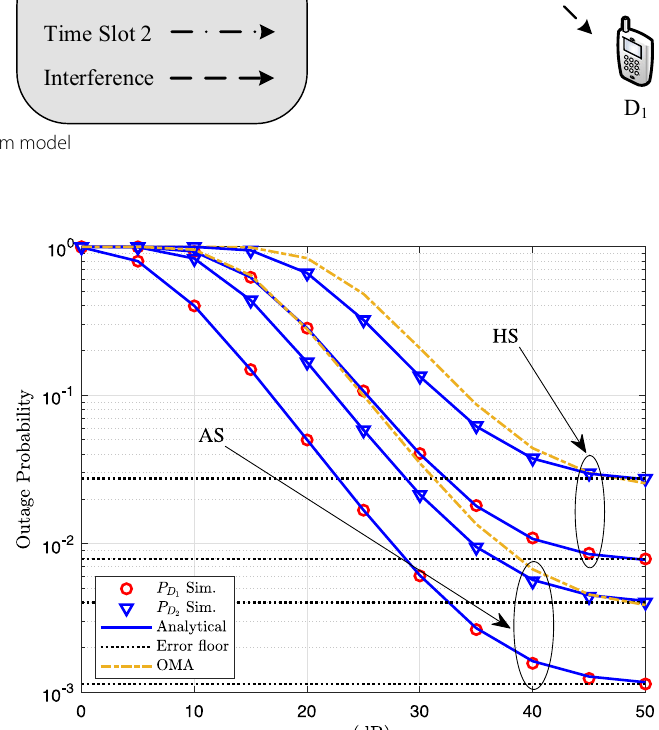
Fig. 2 Outage performance vs ρ (dB) with different satellite